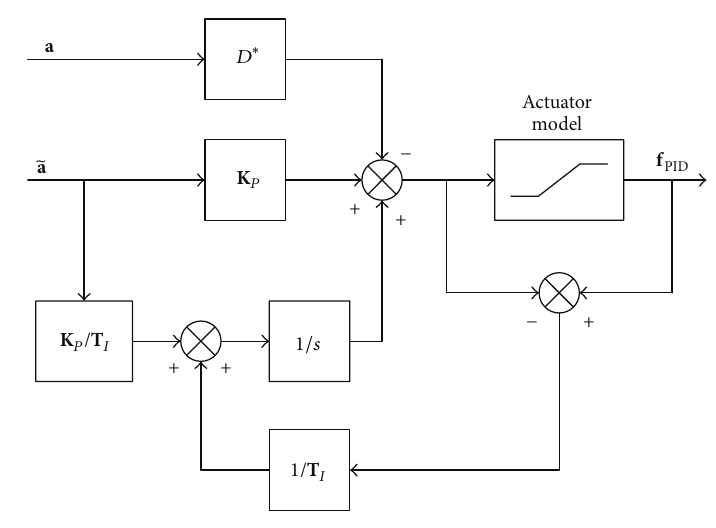
Figure 6: Anti-windup modified